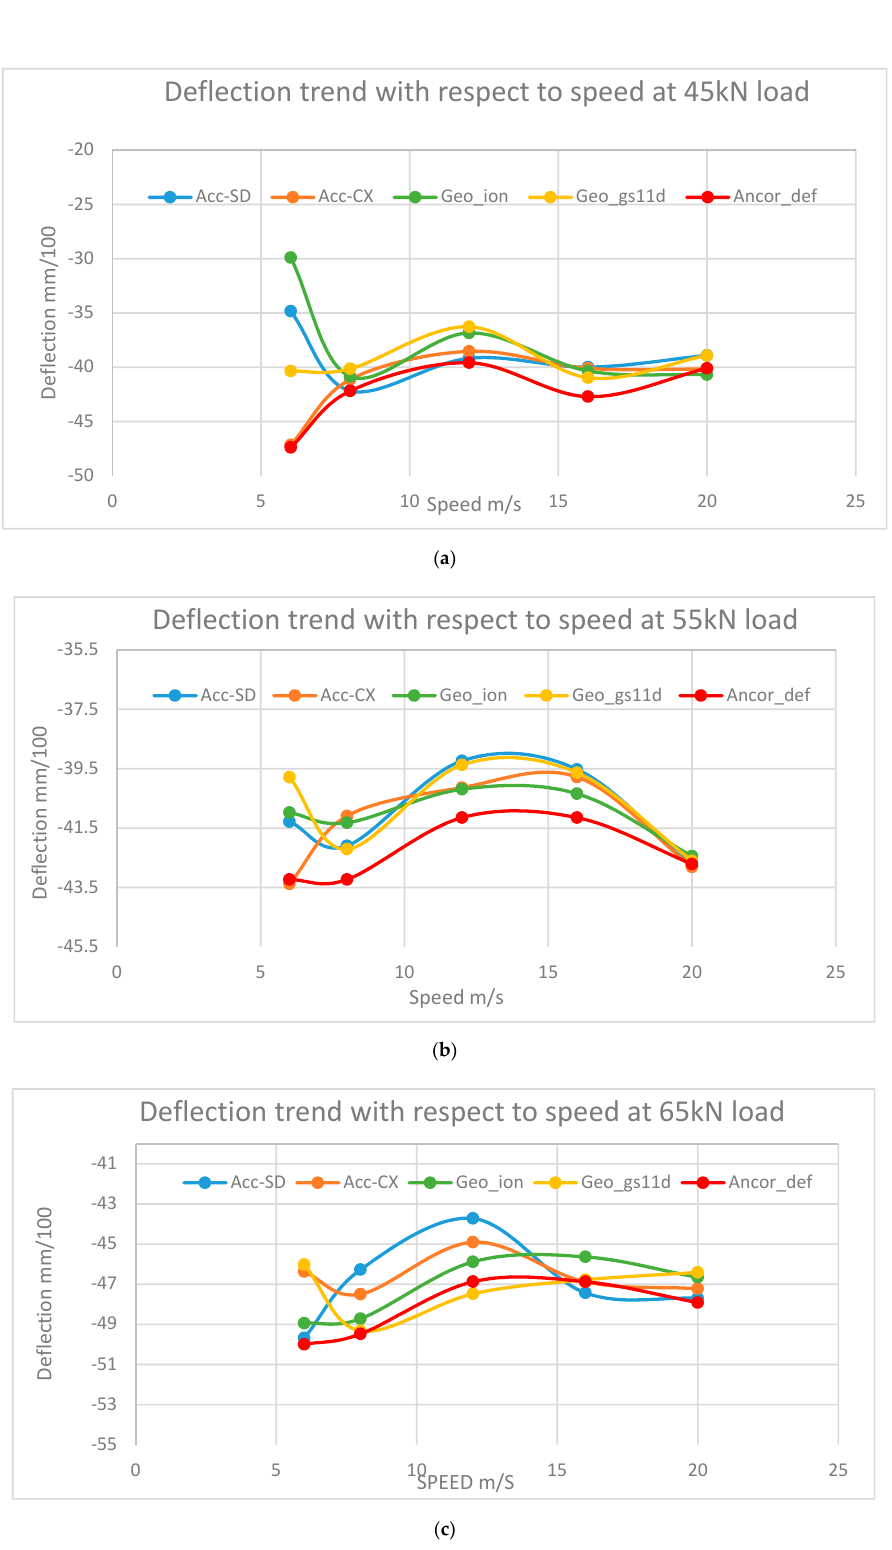
Figure 18. ( a ): Variation of deflections with the loading speed (from 6 to 20 m / s) for load levels 45 kN. ( b ): Variation of deflections with the loading speed (from 6 to 20 m / s) for load levels 55 kN. ( c ): Variation of deflections with the loading speed (from 6 to 20 m / s) for load levels 65